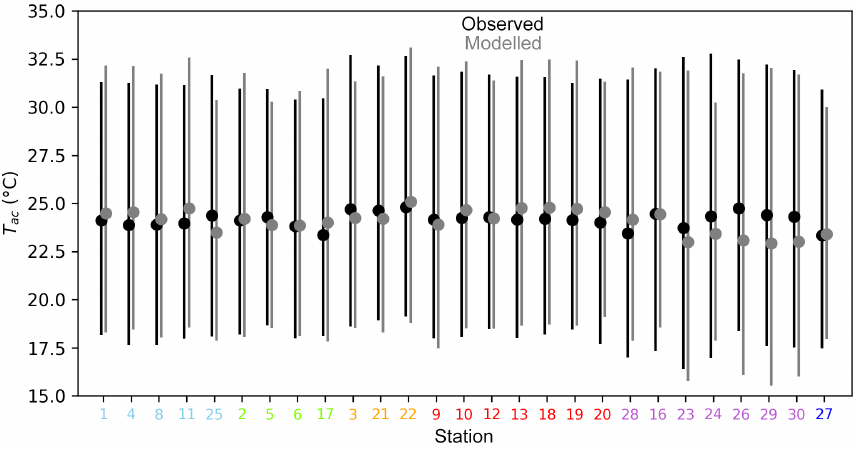
Figure 8. Box plot of modelled T ac (grey) vs. observed T ac (black) for Mawson Lakes, with average, min, and max T ac shown. Box plots are generated from 30min data from the period 15–16 February 2011. The numbers and colours ( x axis) correspond to individual stations and clusters in Fig. 3.